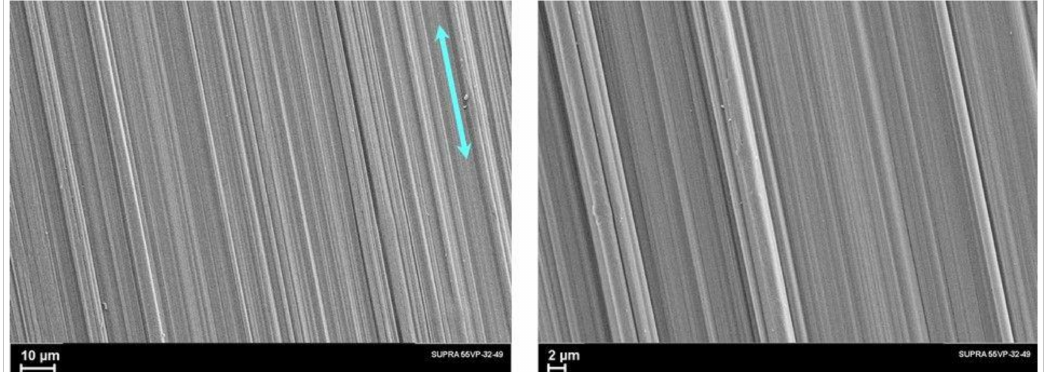
Figure 8. SEM images of the oriented UHMWPE film ( λ = 77) made at different magnifications. The blue arrow shows the drawing direction.